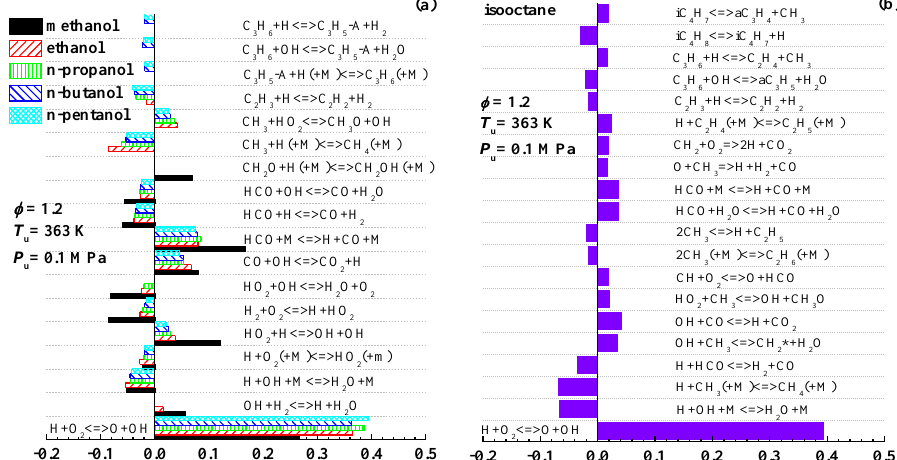
Figure 8. Normalized rate constant sensitivity coefficients on laminar flame speed for ( a ) pure C1–C5 primary alcohols and ( b ) pure isooctane at 363 K, 0.1 MPa and the equivalence ratio of 1.2.